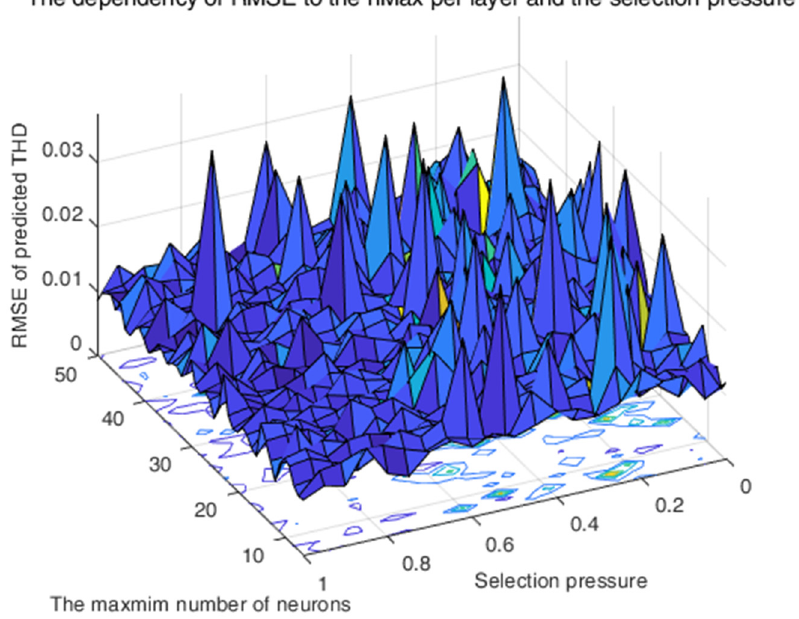
Figure 15. The variation in the error with respect to the number of neurons and the selection pressure.